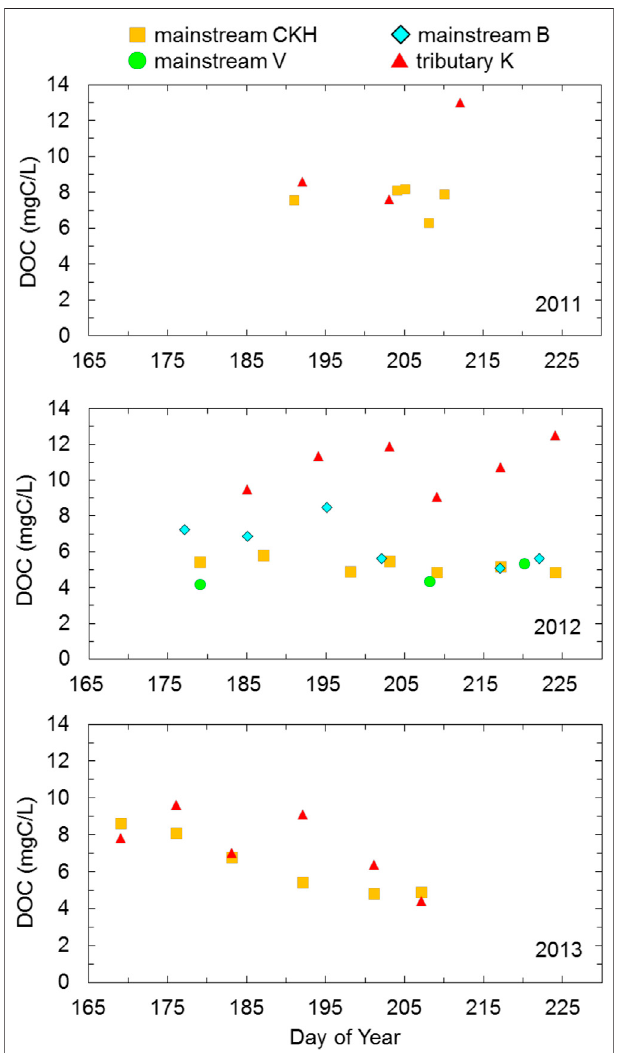
FIGURE 5 | Time series of DOC concentration grouped to the Indigirka mainstream and one tributary for summer observation periods in 2011 – 2013. The mainstream samples were observed at sampling points CKH, B, and V, and the tributary samples were observed at point K.